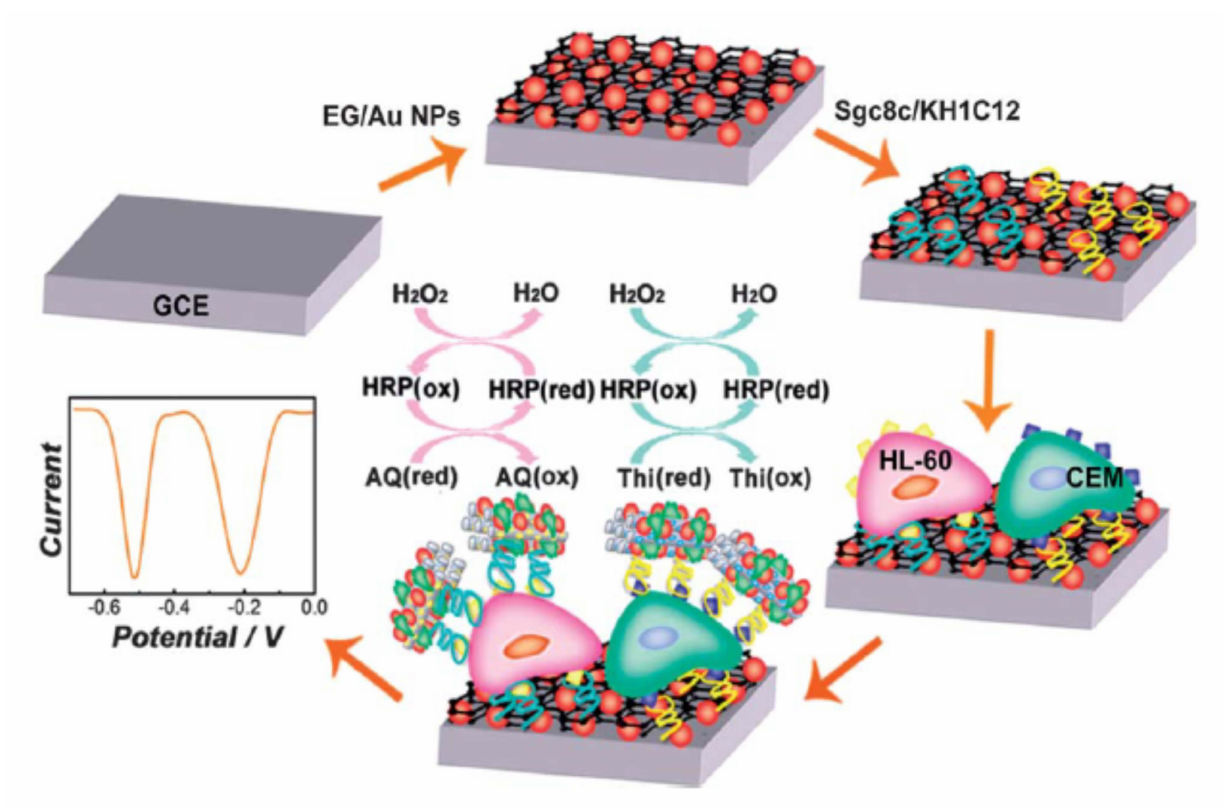
Figure 6. An illustration of the major steps of electrochemical cytosensor construction (reprinted with permission from Zheng et al.